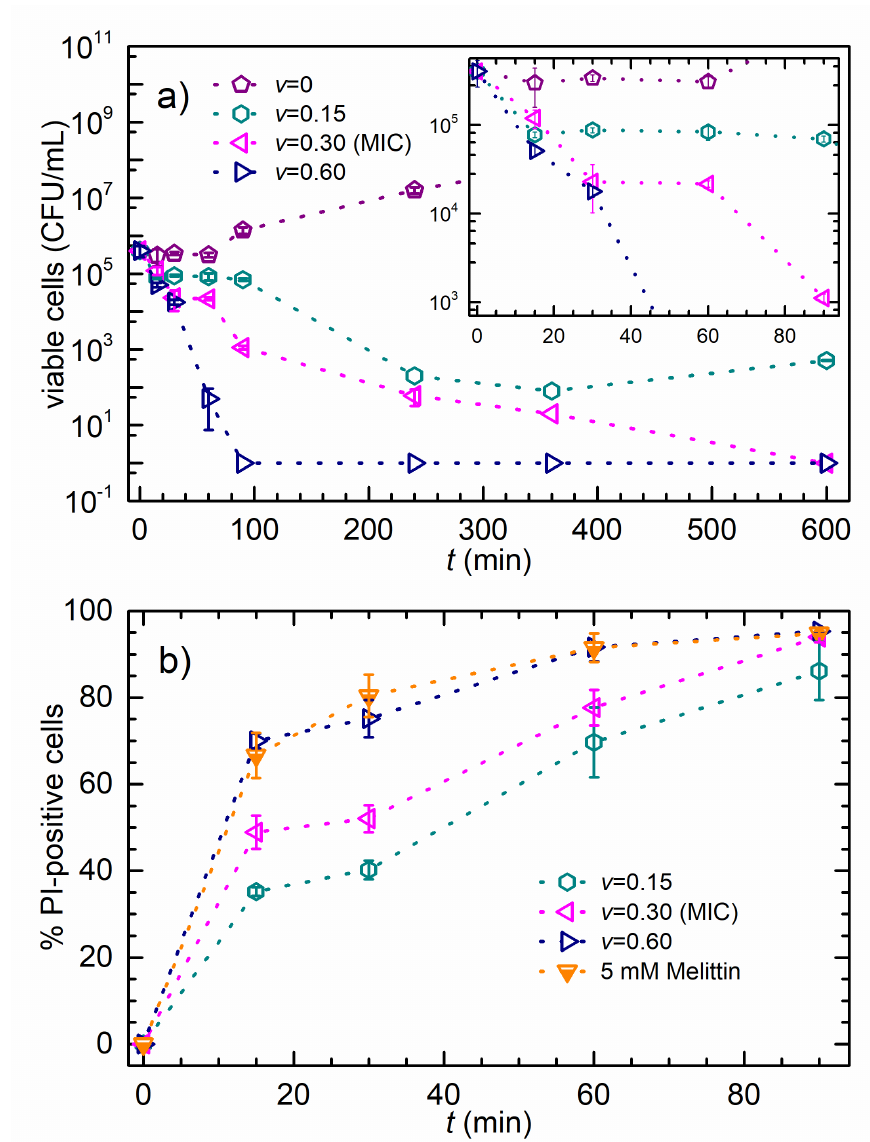
Figure 1. The time-killing and membrane integrity assays . ( a ) Viable-cell concentration versus time. The mean values of viable-cell concentration ± SD for E. coli incubated with di ff erent AgNPs concentrations, as given in the legend. The inset is the first 90 min of the experiment. ( b ) Percentage of PI-positive cells versus time. The data represent the percentage of PI-positive cells ± SD for E. coli incubated with di ff erent AgNPs concentrations, or with Melittin, as given in the legend. Melittin was used as a positive control since it has a strong membranolytic e ff ect [48]. Figure 1b shows that the 2MIC AgNPs and the 5 mM Melittin treatment have almost the same e ff ect on bacterial membrane integrity. After 90 min of treatment with Melittin and AgNPs, most of the cells endured damage and the percentage of the PI + cells is almost the same, for both MIC and 2MIC